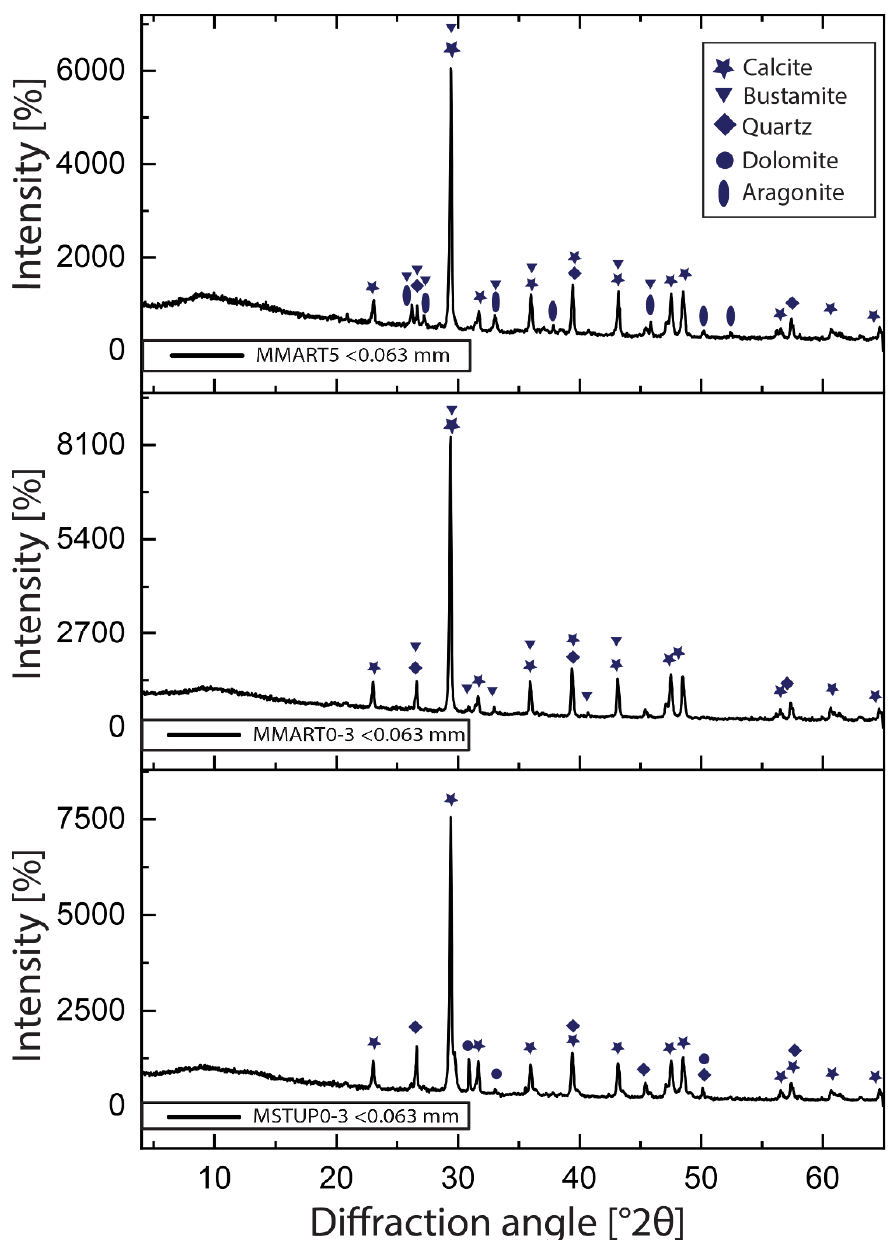
Figure 4. Mineralogical composition of sediments in Mala Stupica Cove and Mala Martinska Cove. Analysed fraction is <0.063 mm.